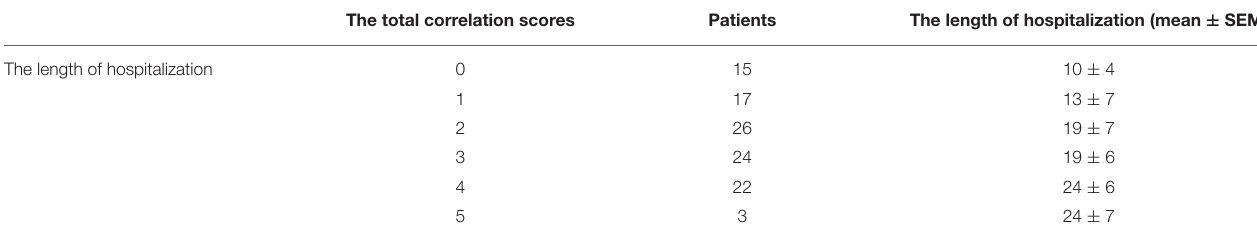
TABLE 8 | The length of hospitalization in the scoring groups.